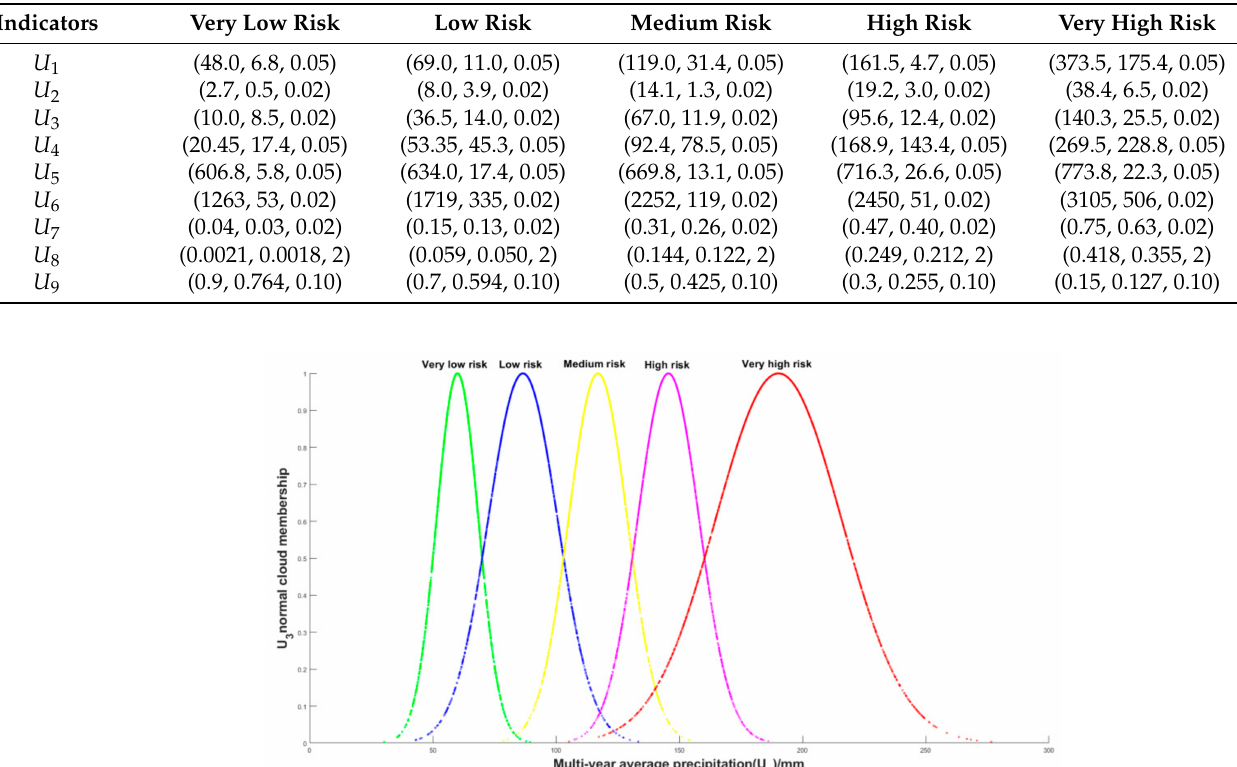
Table 6. Flood disaster risk assessment index normal cloud standard of the Anyang Region.